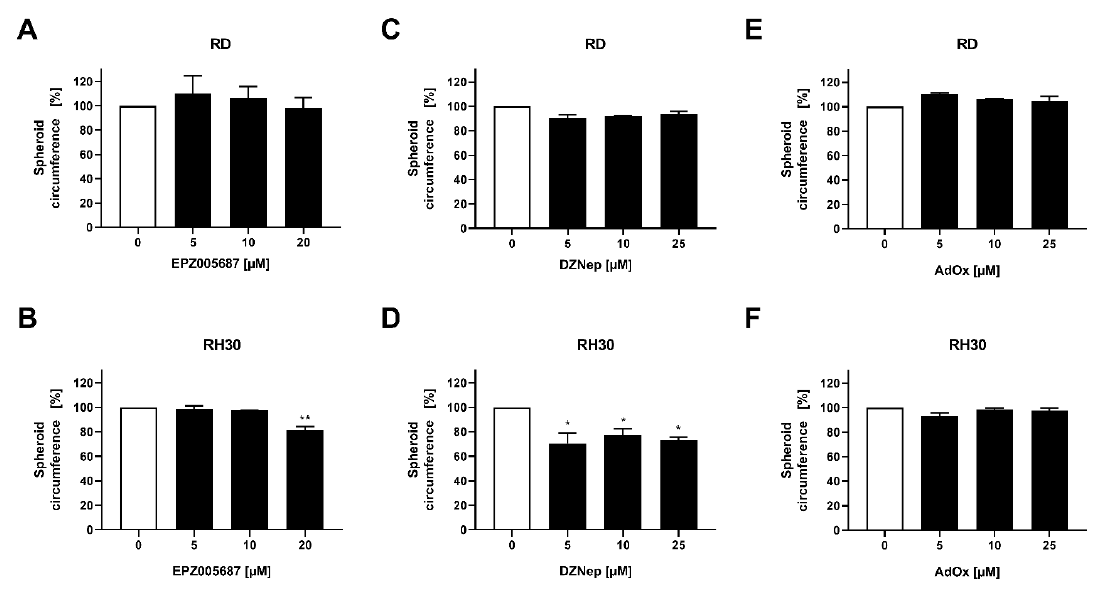
Figure 8. Effect of the EZH2 inhibitors on spheroid circumference in RMS cell lines. Inhibitory effect of EPZ005687 ( A , B ), DZNep ( C , D ), and AdOx ( E , F ) on RD (upper row) and RH30 (lower row) cells on spheroid circumference. The untreated control was set as 100%. Error bars represent mean +/ − SEM ( n = 3.) p * ≤ 0.05, p ** ≤ 0.01 indicates statistical significance.